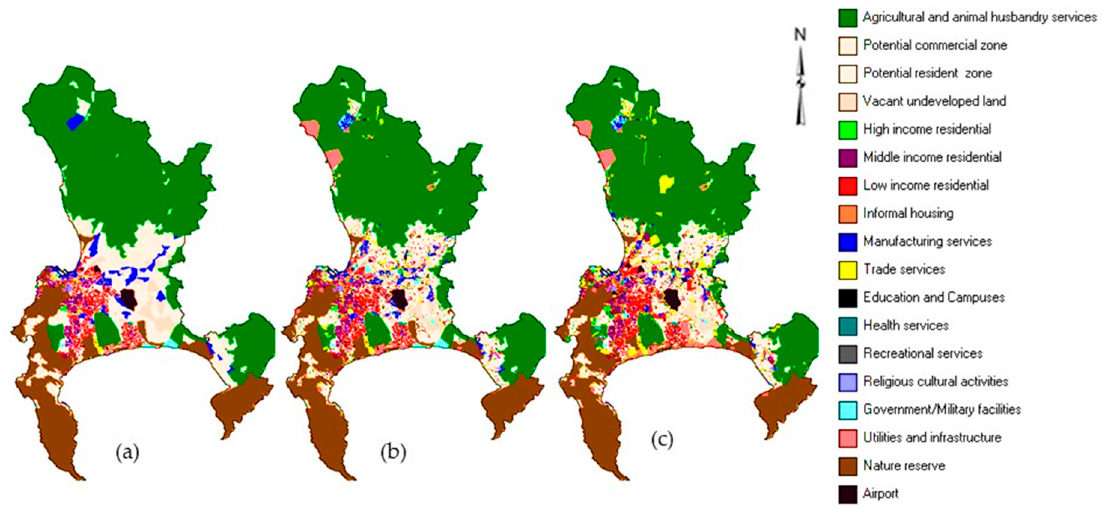
Figure 2. Land use maps for ( a ) 1995 ( b ) 2005 ( c ) 2010 that were used in the model calibration and validation.